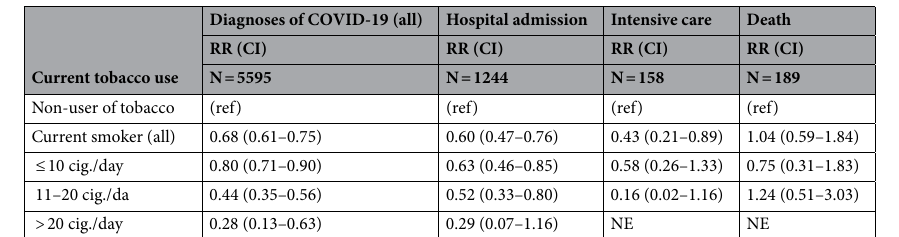
Table 3. Adjusted a Risk Ratio (RR) and 95% Confidence Intervals (CI) of COVID-19 for current exclusive smokers compared to non-users of tobacco among clients of the public dental care clinics in Stockholm region (n = 365,627). NE not estimated because of the low number of events. a Adjusted for sex, age (continuous), education, income (continuous), occupational risk, country of birth, and cohabitation.